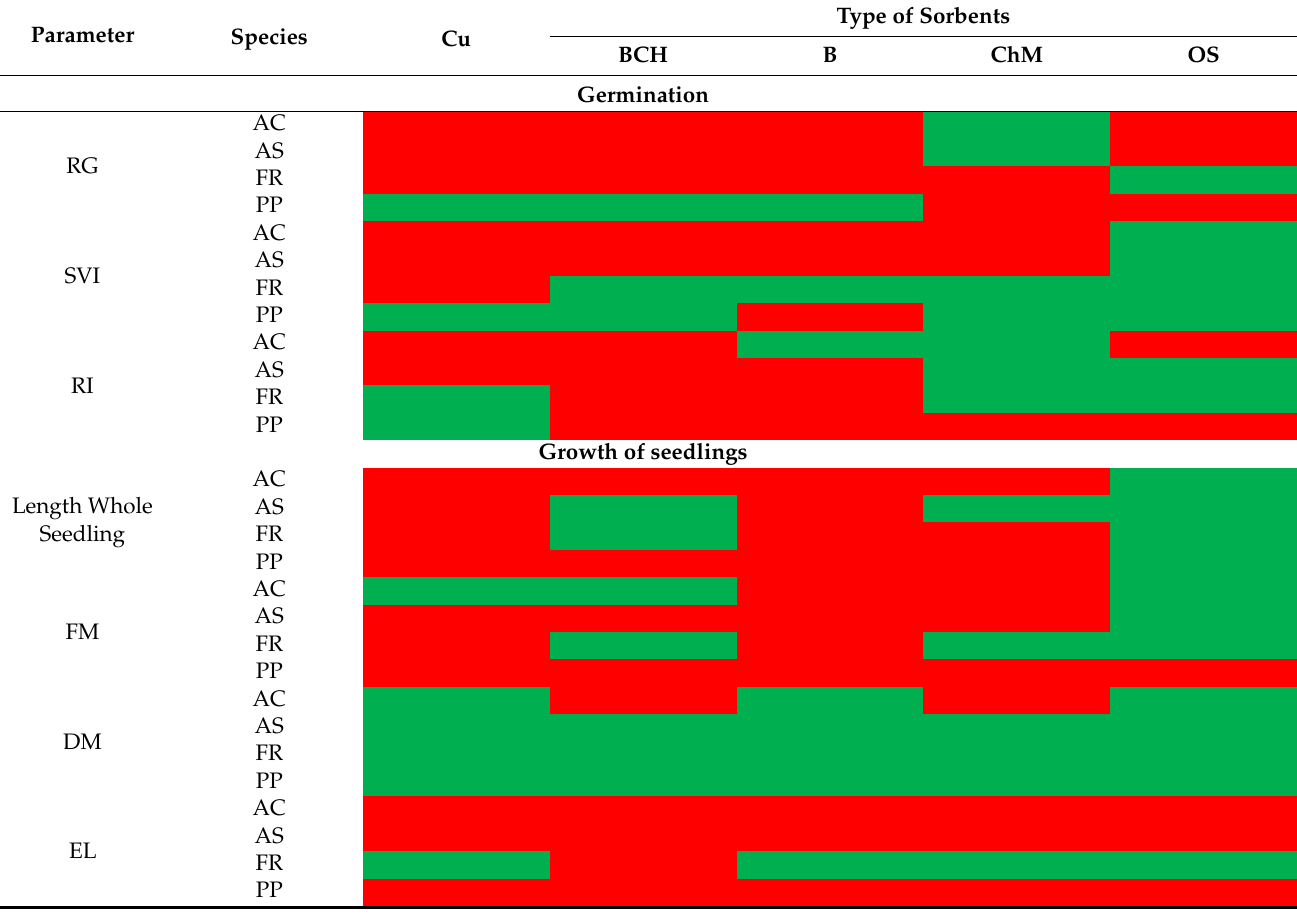
Table 2. Comparison of the impact of soil with an increased content of Cu and with the addition of sorbents (BCH—biochar, B—bentonite, ChM—chicken manure, OS—organo-zeolitic substrate) on selected parameters of germination and growth of the studied species of grasses (AC— Agrostis capillaris , AS— A. stolonifera , FR— Festuca rubra , PP— Poa pratensis );